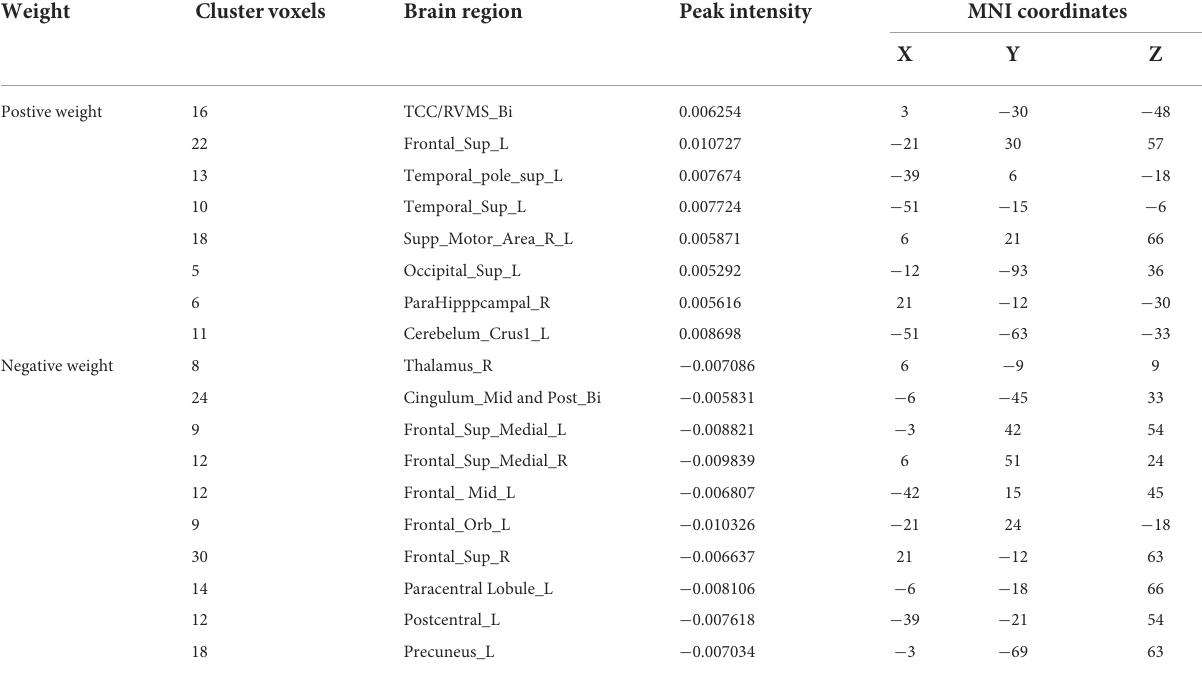
TABLE 2 Discriminative features to discriminate MWoA from HCs. Weight Cluster voxels Brain region Peak intensity MNI coordinates